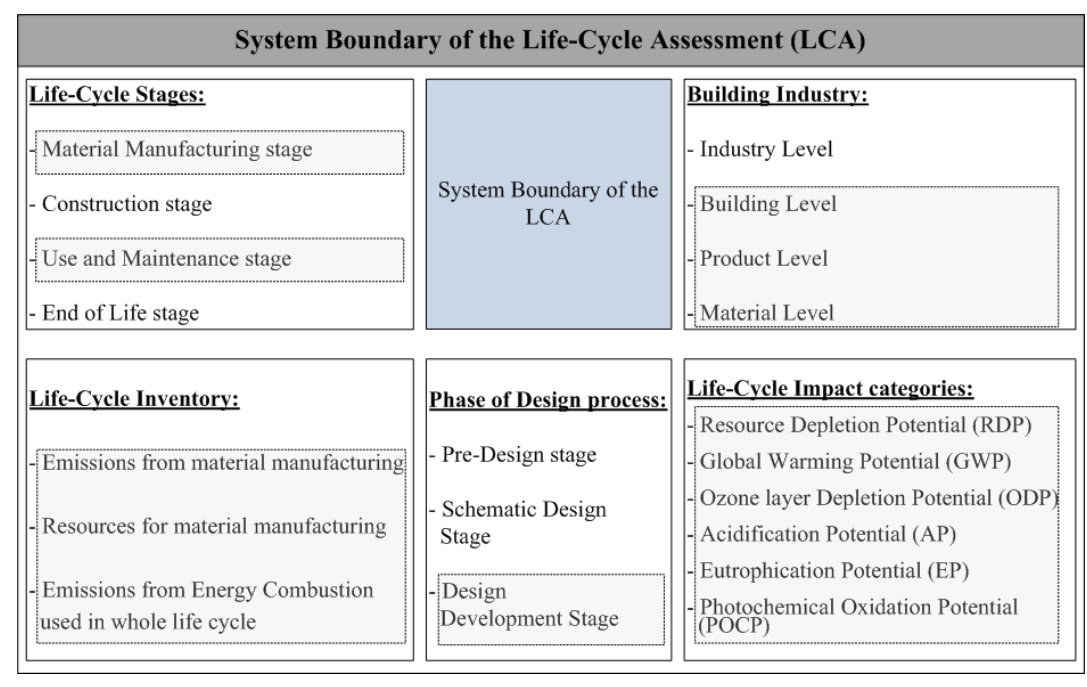
Figure 4. System boundary of the